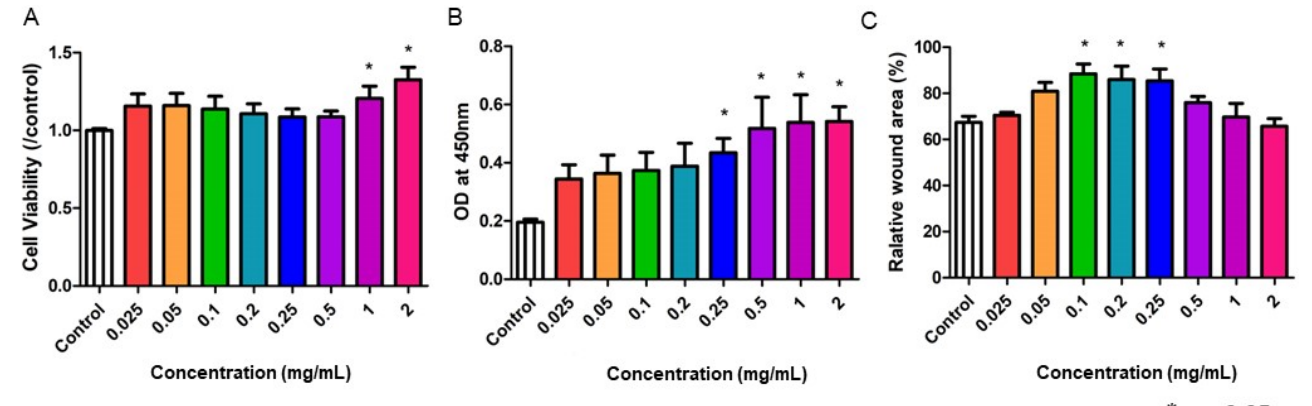
Figure 5. The effect of NF3 on MSCs. Different doses of NF3 were supplied to MSCs cultivation. ( A ) MTT. The data showed that a high dose of NF3 (1–2 mg/mL) promoted cell viability in MSCs ( p < 0.05). ( B ) BrdU. NF3 (0.5–2 mg/mL) enhanced the proliferation of MSCs. ( C ) Scratch test. A medium dose of NF3 (0.1–0.25 mg/mL) increased the mobility of MSCs.